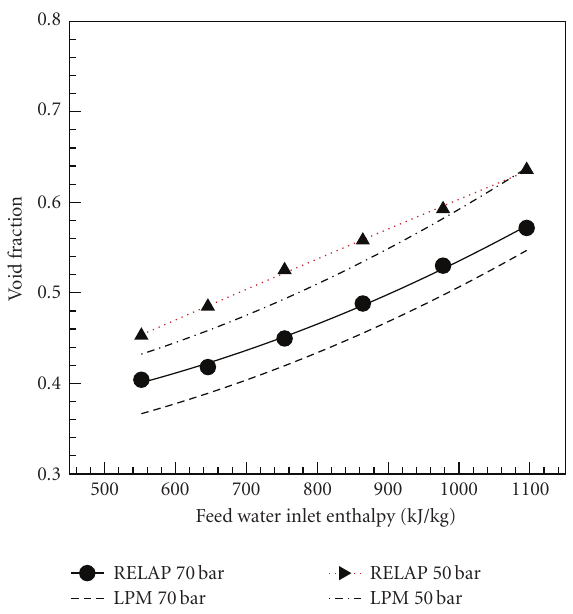
Figure 9: Variation of void fraction with FIE.